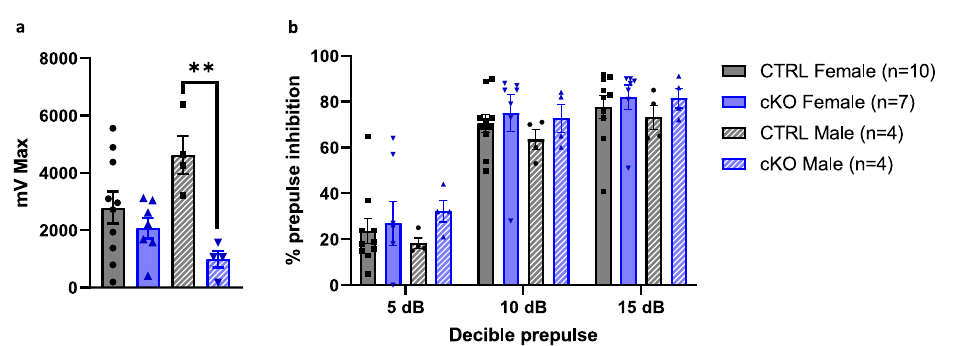
Figure 4. Male neuronal Ca V 1.2 cKO mice display impaired startle response. ( a ) Male cKO mice have significantly lower acoustic startle response to the auditory startle pulse compared to CTRL littermates. Female cKO mice do not differ from female CTRL mice in acoustic startle response. ( b ) All groups display normal prepulse inhibition of the acoustic startle response, and no sex or genotype differences were observed. Data are expressed as mean ± s.e.m, using SR-Lab, www. sandi egoin strum ents. com/ produ ct/ sr- lab- start le- respo